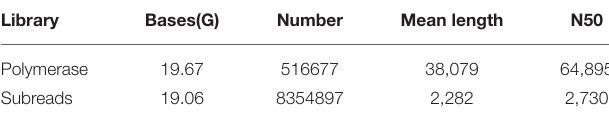
TABLE 1 | Full-length transcriptome sequencing